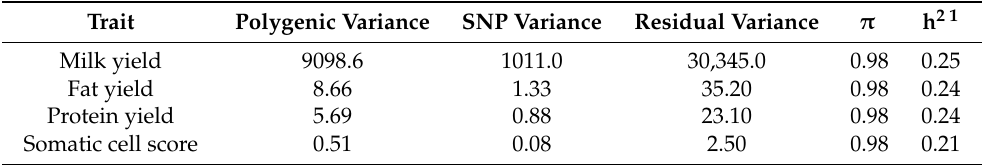
Table 1. Prior across-breed variance components fitted in the pedigree-based best linear unbiased prediction (PBLUP) and single-step BayesC model (ssBC)